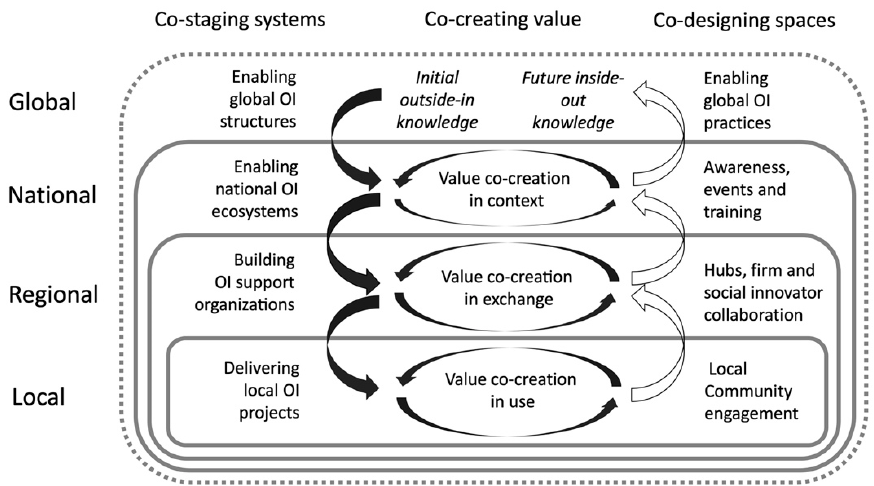
Figure 2. Modelling Value Creation in Open Innovation in University–Industry Collaboration.